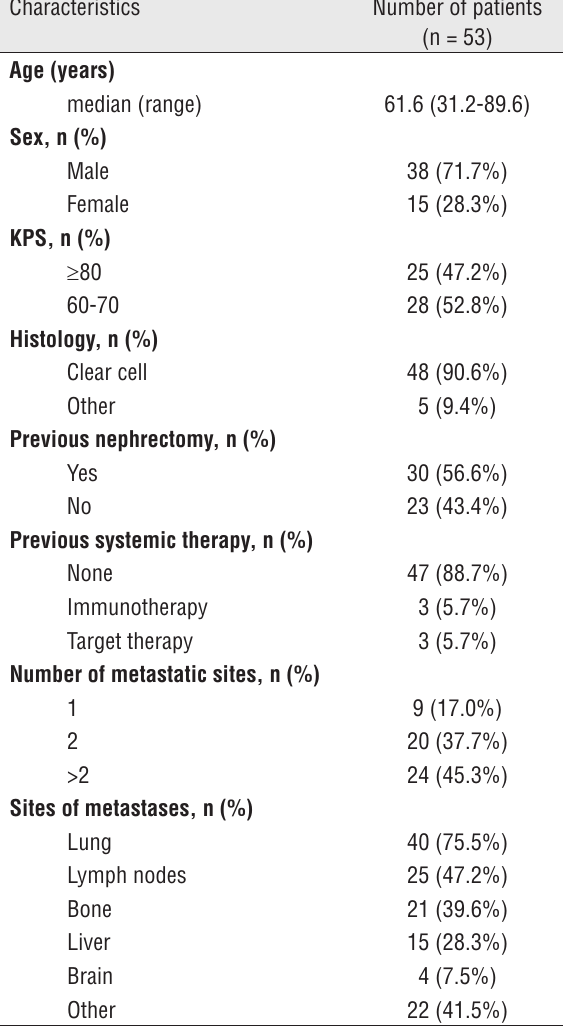
Table 1 - Patient characteristics.